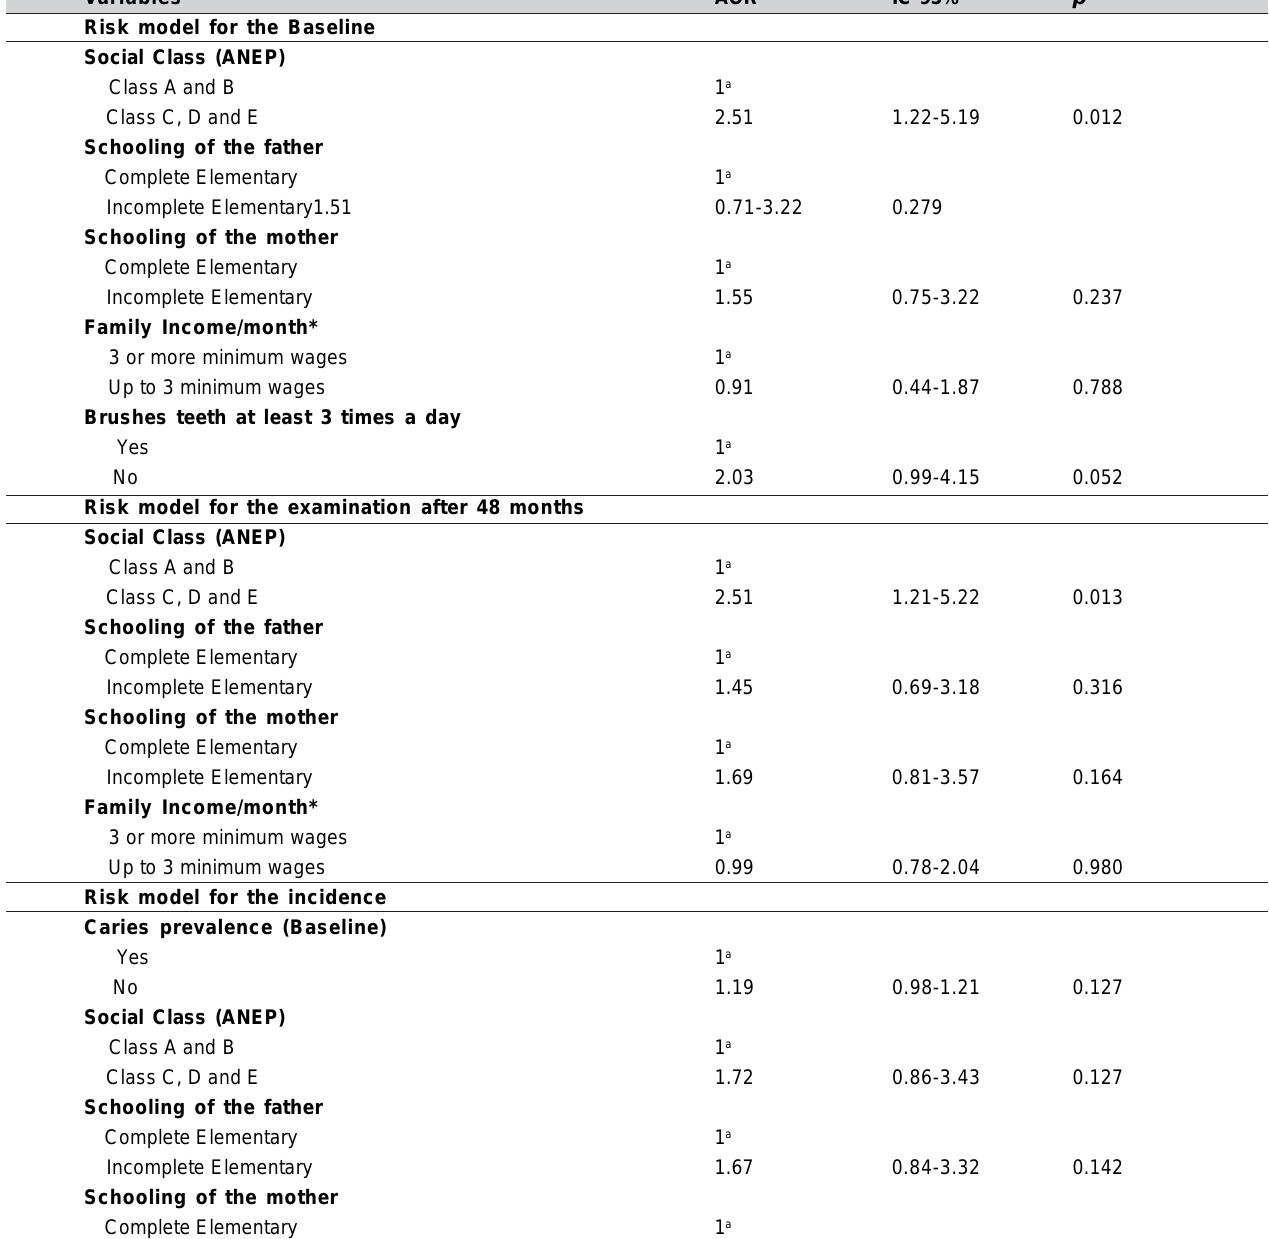
Table 3 - Multivariate logistic regression analysis according to caries prevalence (DMFT=0 vs DMFT>0) and incidence (Inc d”3 vs Inc >3) in the adolescents. Água Doce-SC,